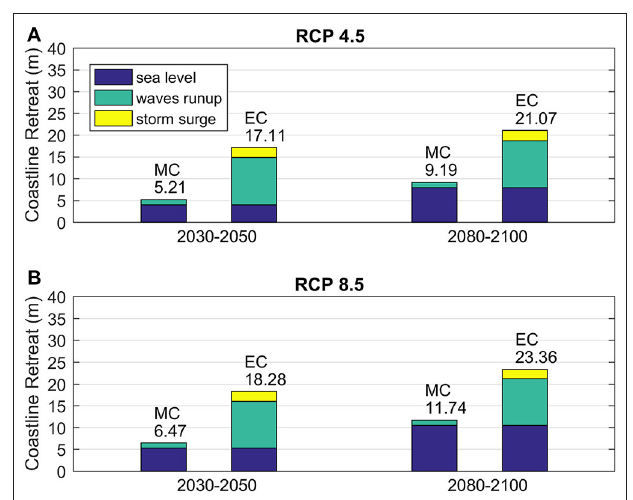
FIGURE 9 | Average value of the coastline retreat in metres for all the 869 beaches. The relative contribution of mean sea level rise (blue), wave runup (green) and storm surge (yellow), are presented under RPC4.5 scenario (A) and RCP8.5 scenario (B) for mid-century (2030–2050) and the end of the century (2080–2100). Results under mean conditions (MC, first and third columns) and under extreme conditions (EC, second and fourth